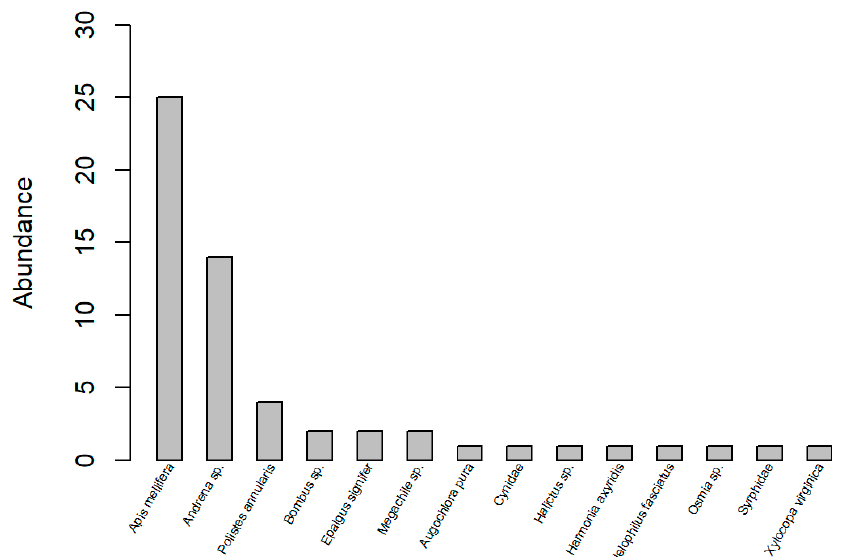
Figure 3. Abundance of each pollinator taxon identified from planted and feral P. calleryana . Dominant taxa were European honeybee ( Apis mellifera ) and mining bees ( Andrena spp.), and other taxa included wasps, native bees, hoverflies, and other flies.